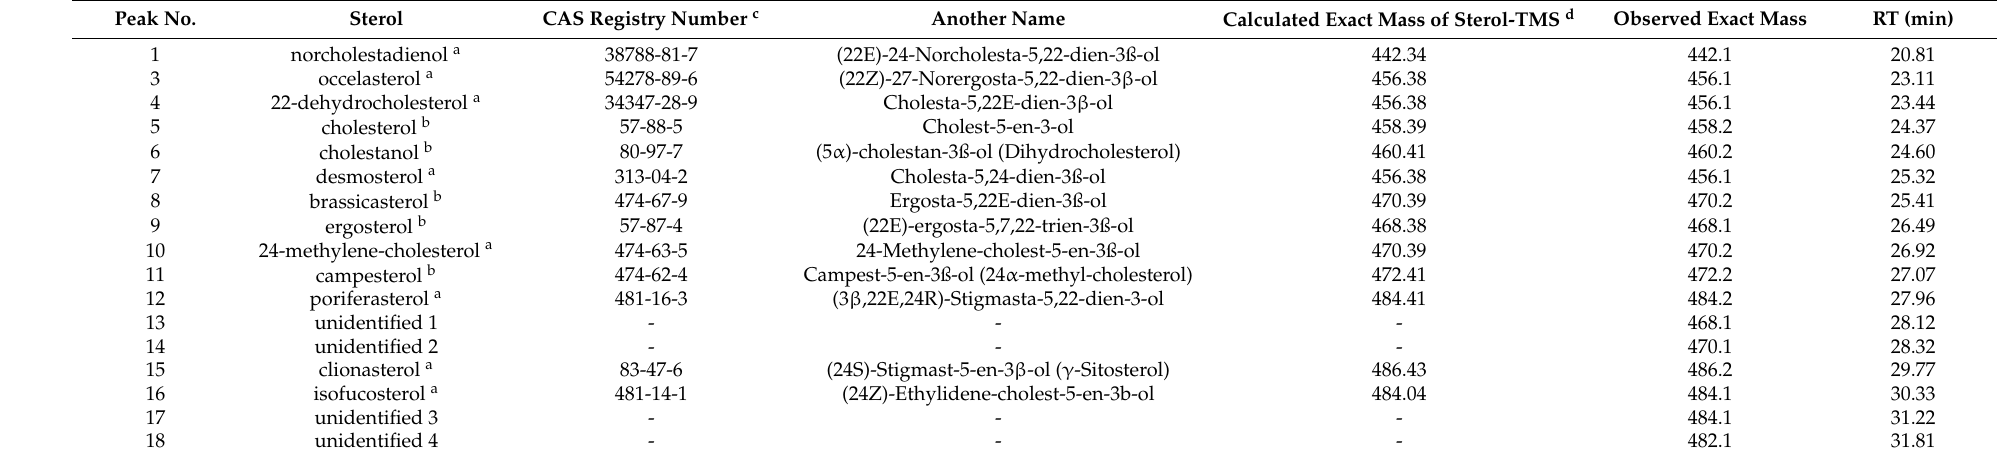
Table 2. List of identified and quantified sterols from the studied